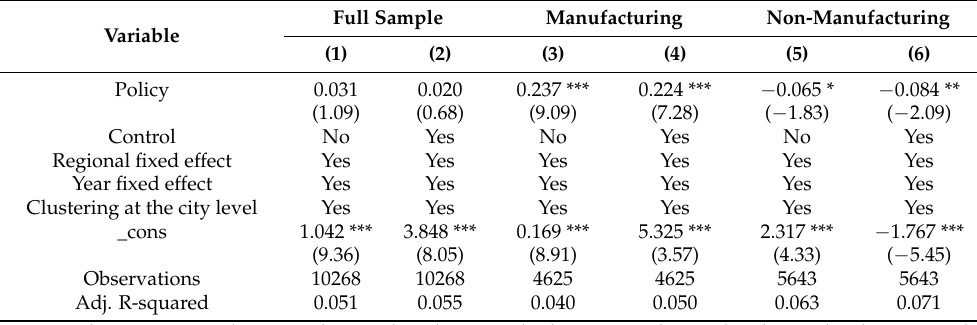
Table 11. Effects of low-carbon city construction (LCC) on technological innovation of listed companies.